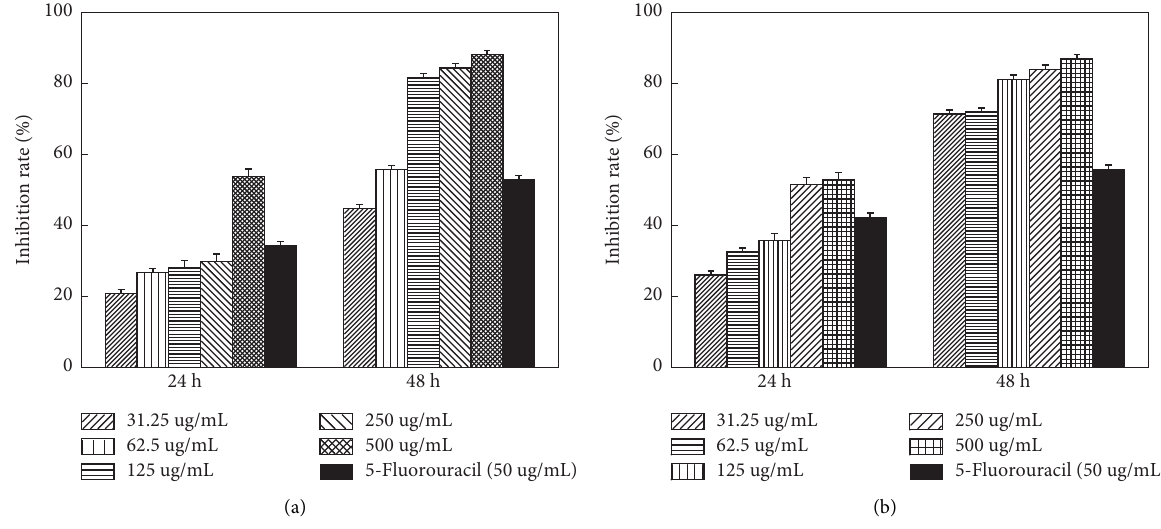
Figure 6: Inhibition rate of Sao-S cells in osteosarcoma (a) and bladder cancer T24 cells